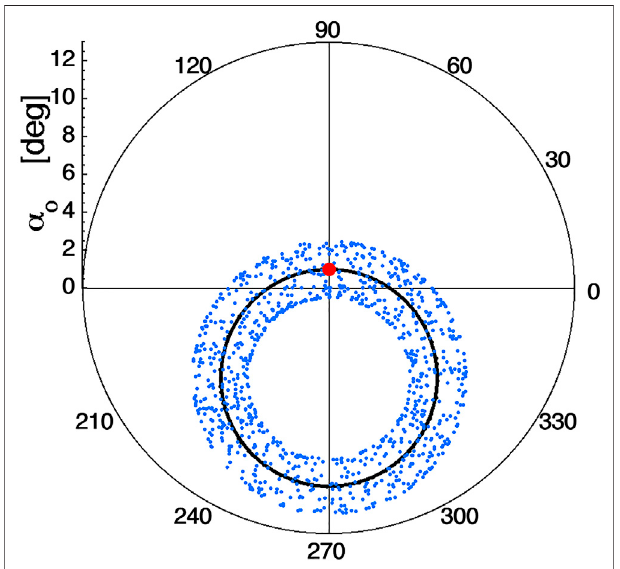
FIGURE 4 | For 1,000 protons of energy 700-keV all launched from the equatorial plane at L (cid:1) 6.6 with ( α o , ϕ o ) (cid:1) (1 o , 90 o ) (marked with the large red dot), the ( α o , ϕ o ) values for the fi rst northward-going equatorial crossing is plottedasablue point.Each ionwassubjectedtoa3 o de fl ection whenit was halfway to its fi rst mirror point. The black circle is the circle of ( α o , ϕ o ) values for ions that are not subjected to angular scatterings.